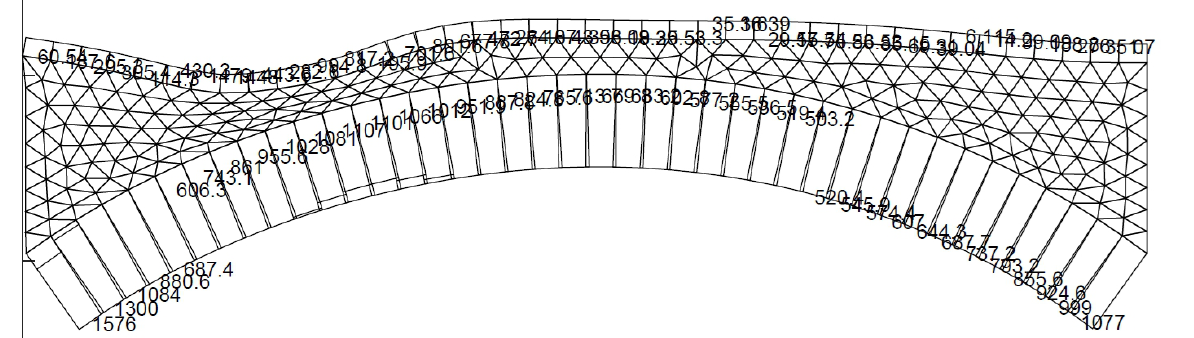
Figure 3. The minimum stresses [kPa] and crack depths in the Ponikla central span arch. The displacements are 1000 times scaled up.